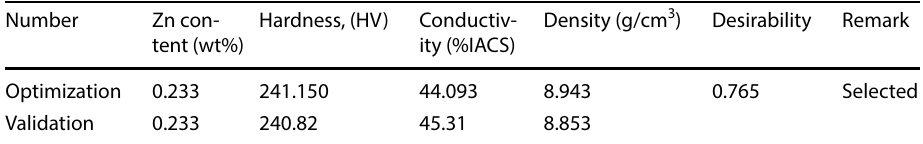
Table 2 Optimization and validation of experimental